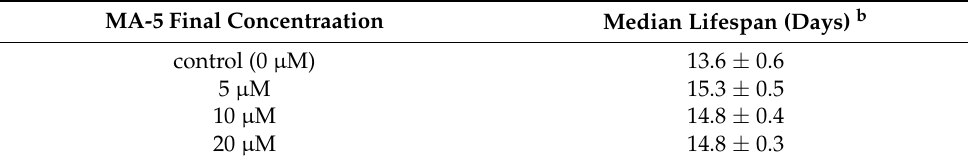
Table 1. Median lifespan of ATU3301 animals a treated with MA-5.